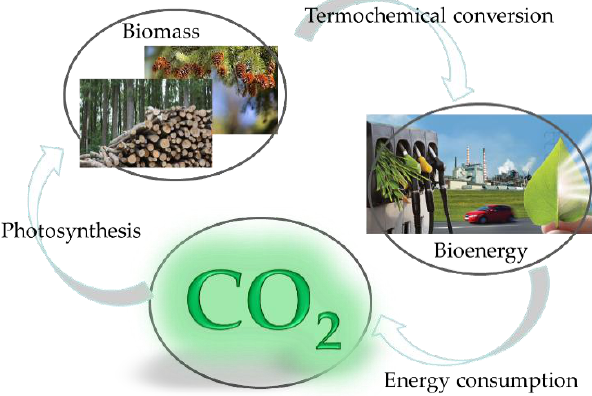
Figure 1. Biomass life cycle.